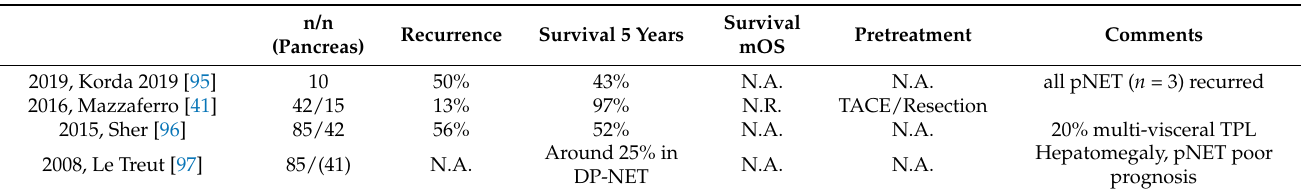
Table 5. Overview of selected studies providing outcomes for liver transplantation in patients with metastatic